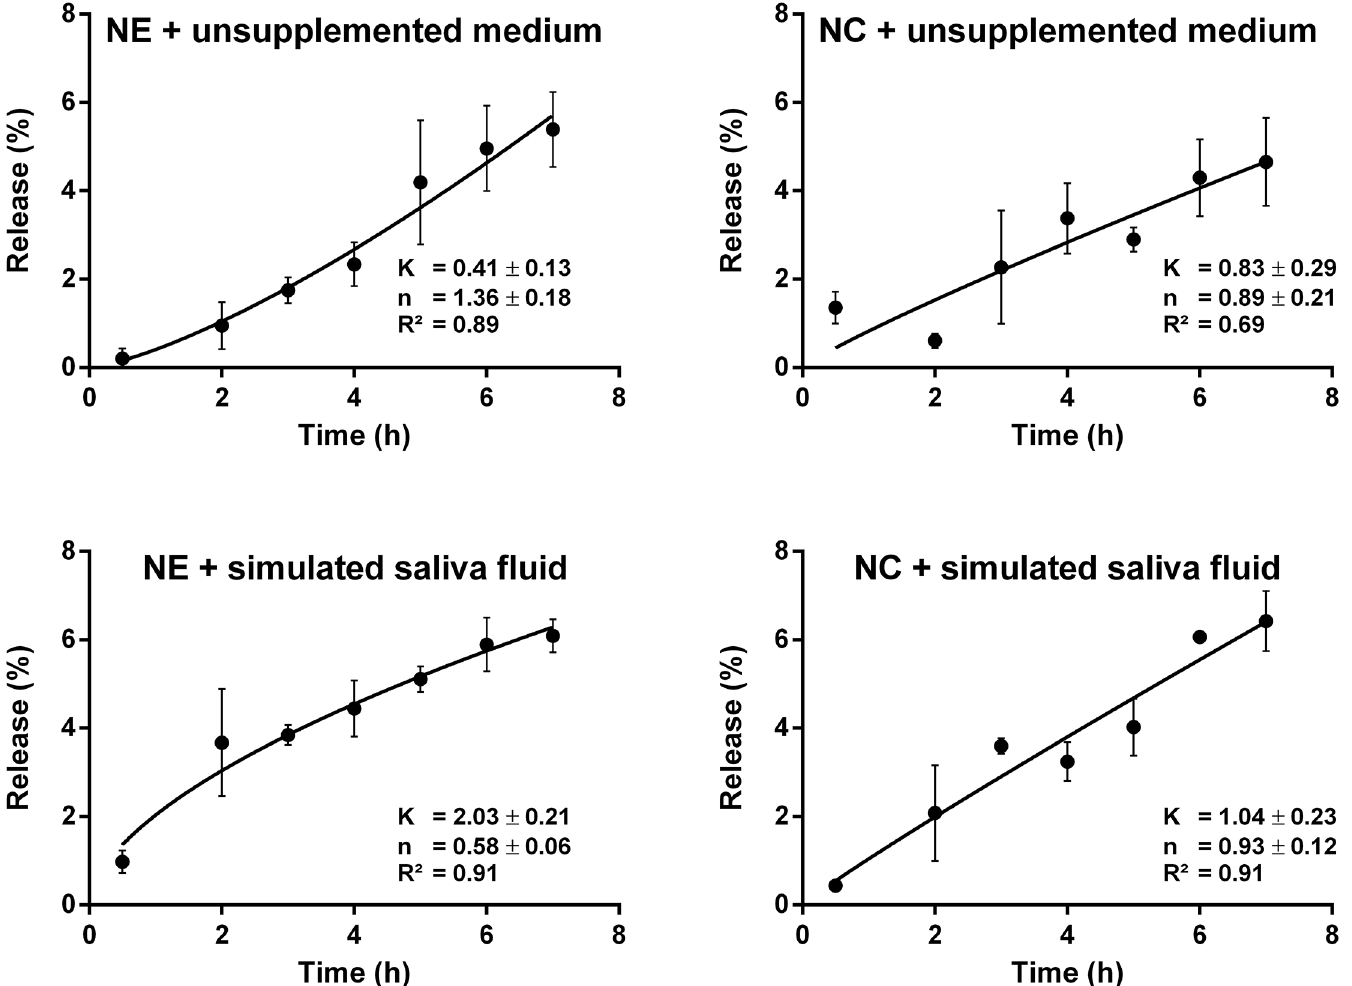
Fig 2. In vitro capsaicin release of nanoformulations. The capsaicin release of chitosan-coated nanocapsules (NC) and nanoemulsions (NE) into different buffers was carried out at 37°C. Investigated media were Ham's F12 Nutrient Mixture without supplements and a simulated saliva fluid. Non-linear fits were calculated according to the model of Korsmeyer and Peppas [25]. Data are mean values ± SD (n =